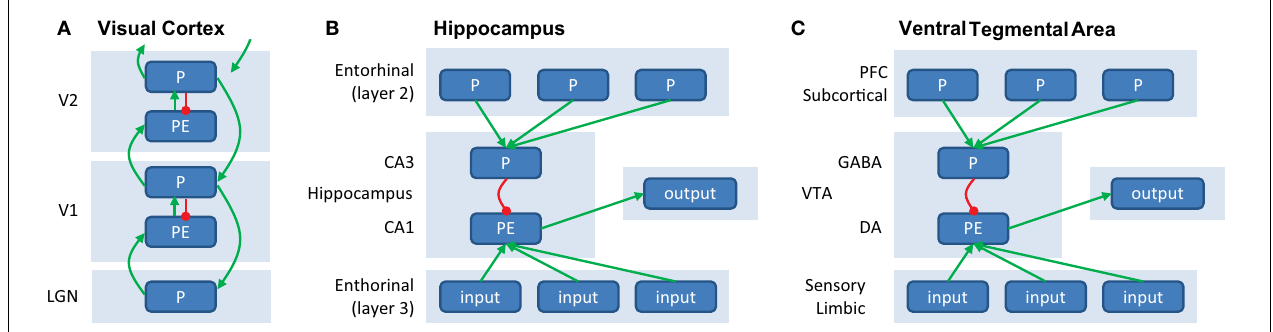
FIGURE 2 | (A) Generation of prediction errors within a cortical ensemble. PEs are generated by mismatch between predictions (P, in agranular layers, inhibitory) and input (originating from L2/3 from lower unit, arriving in L4, excitatory).The PE unit therefore reflects the difference between input and prediction, and activity in P units will be updated to minimize this discrepancy. Predictions (P) are both sent forward as input to a hierarchically higher level (via supragranular layers, L2/3) and backward to update predictions at a lower level (via infragranular layers, L5/6). (B) Generation of PEs within the